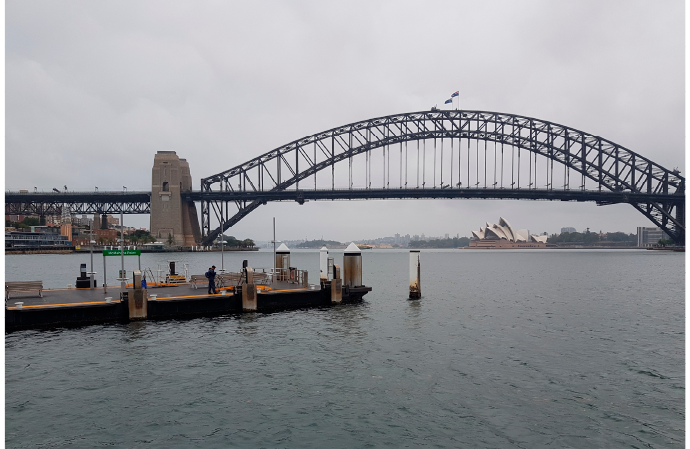
Figure 1. A ferry commuter floating pontoon located at McMahons Point in Sydney Harbour, Aus- tralia.